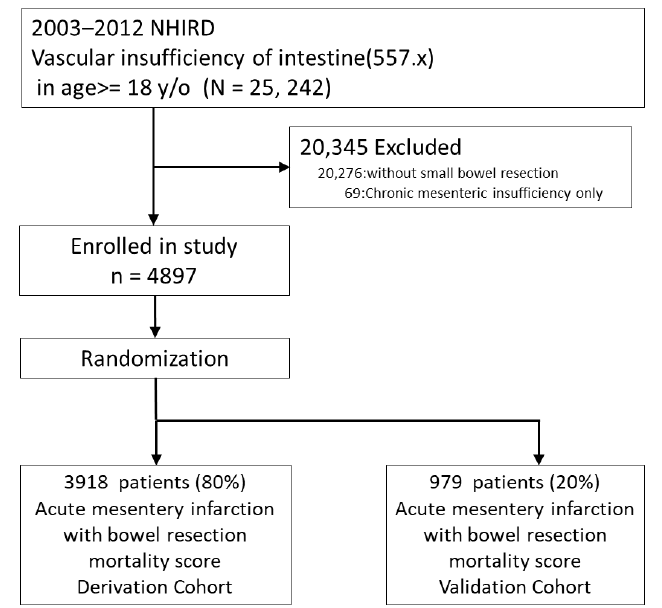
Figure 1. Flowchart of the study.